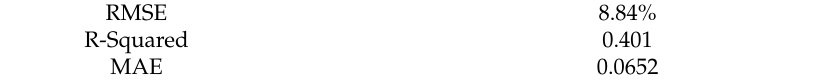
Table 3. Logistic regression model measures of fit.